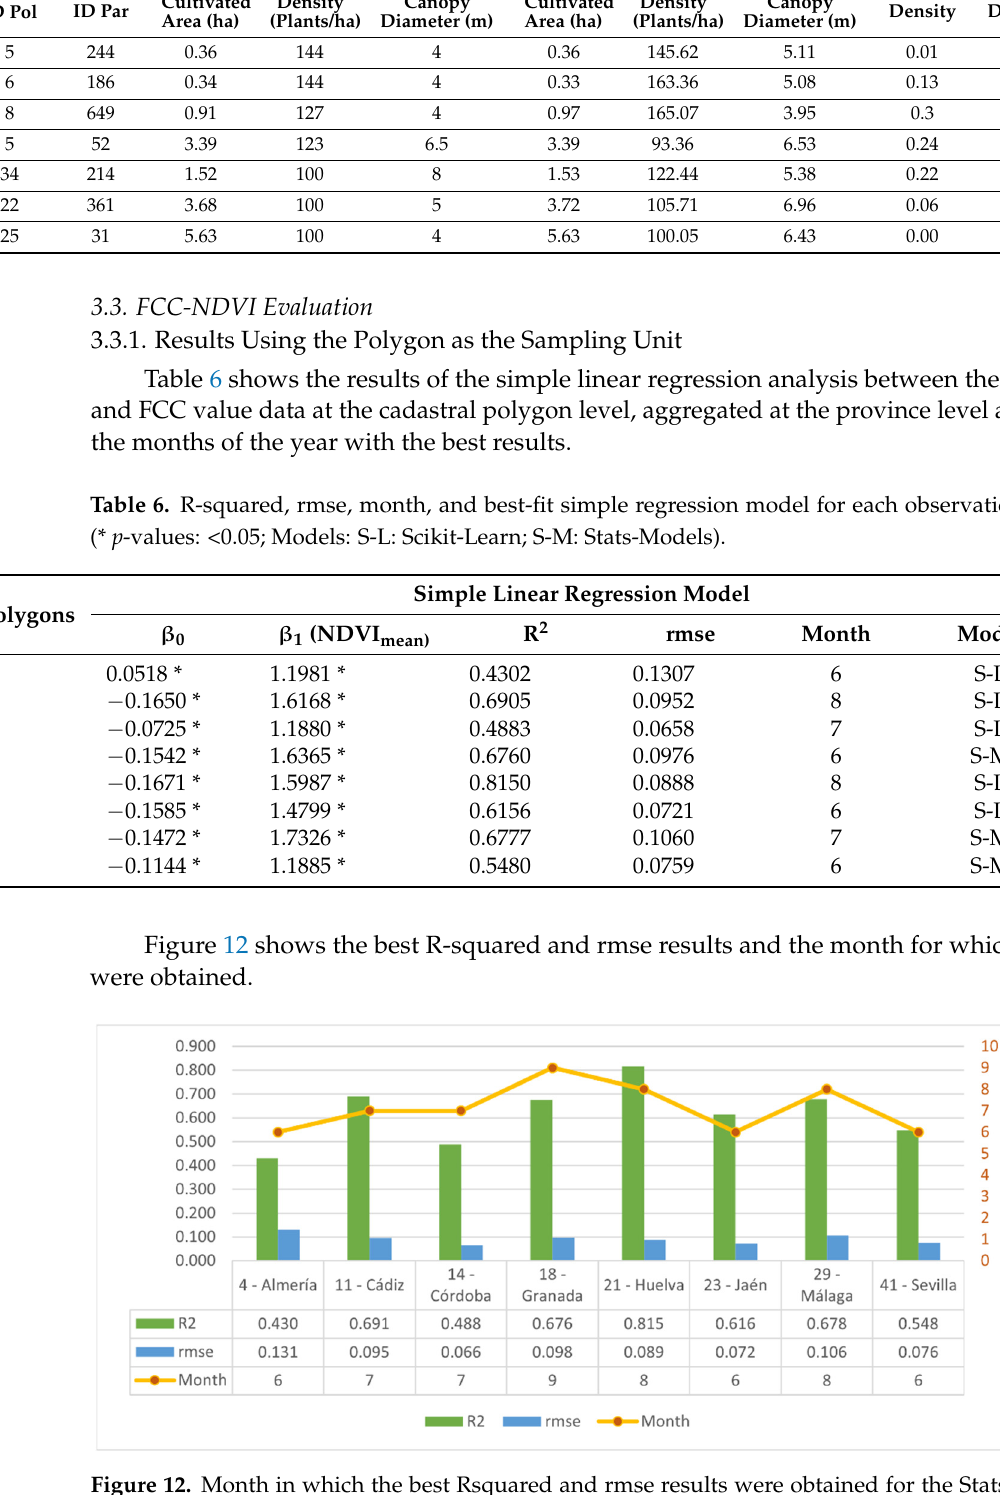
Table 7. R-squared, rmse, month and best fit model for simple regression (* p -values: <0.05).